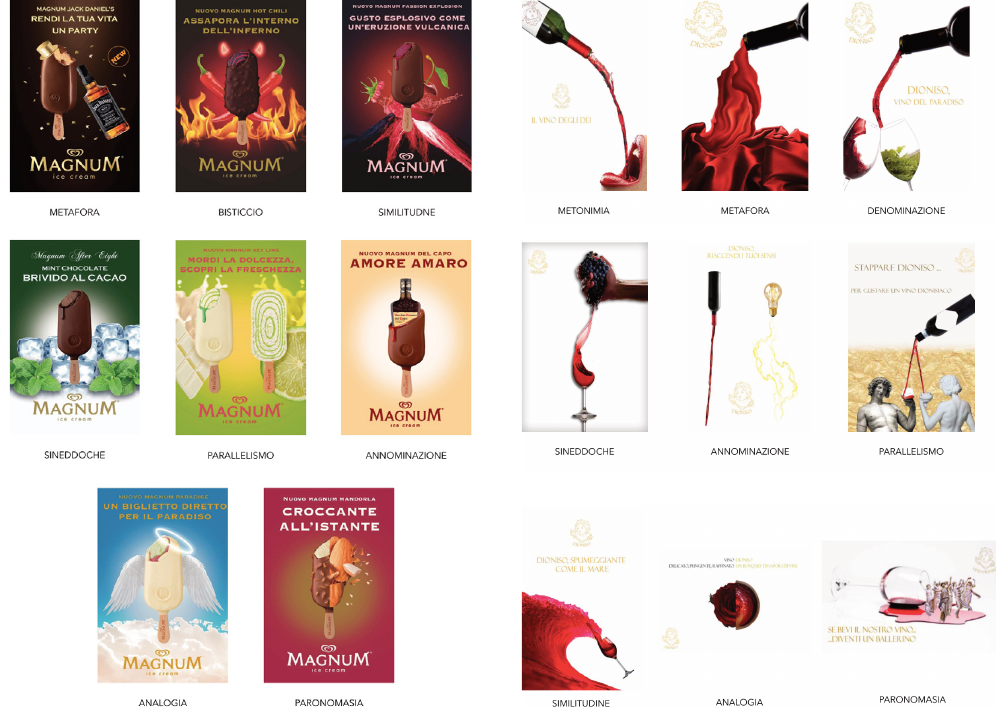
Figs. 2a, 2b Association figures